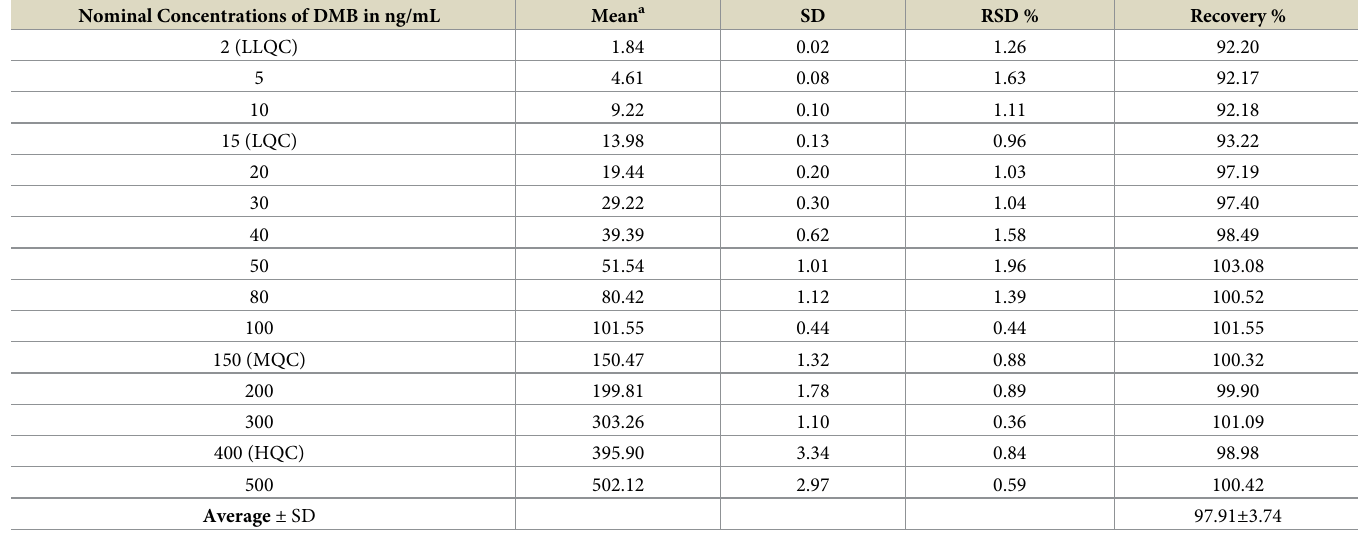
Table 1. Data of back-calculated DMB concentrations for the calibration standards from the RLM matrix. Nominal Concentrations of DMB in ng/mL